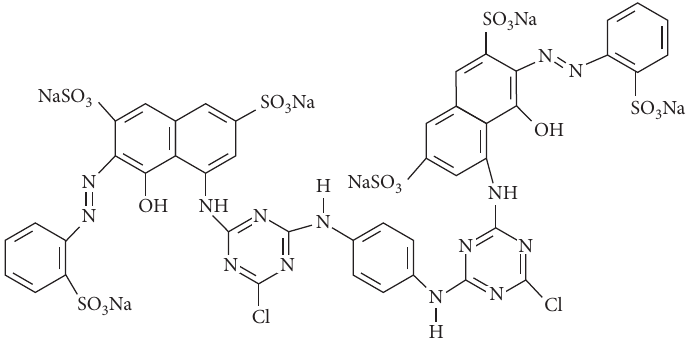
Figure 1: Structure of reactive red 120